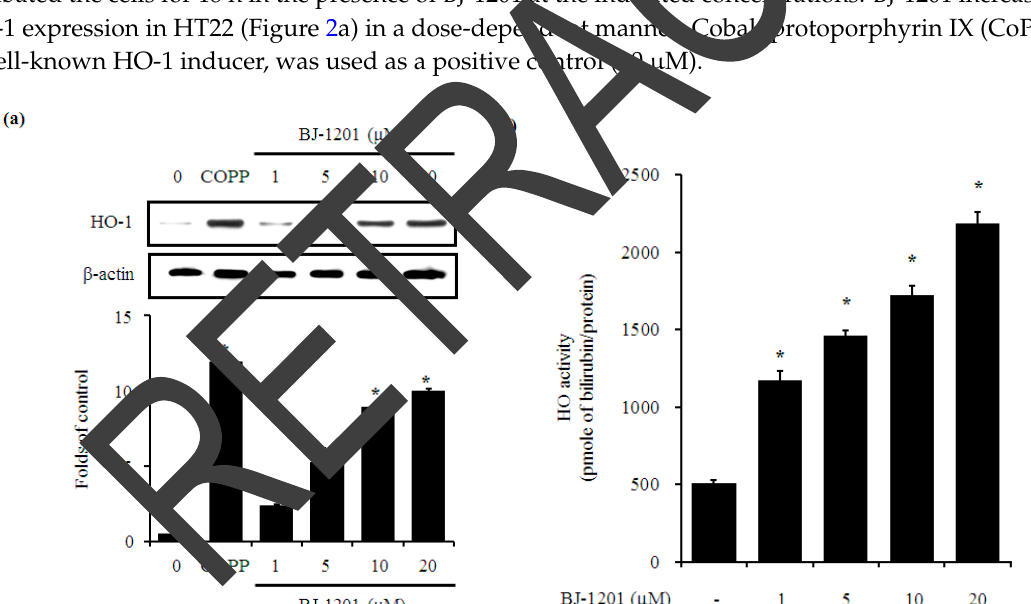
Figure 2. Effects of BJ-1201 on HO-1 expression in HT22 cell. ( a ) Cells were incubated for 18 h with sample (1–20 μ M). Expression of HO-1 was determined by western blot analysis; ( b ) HO activity was determined via bilirubin formation at 12 h after treatment with various concentrations of BJ-1201. Each data represents the mean ± S.D. of three independent experiments are shown. CoPP (10 μ M) was used as the positive control. * p < 0.05 compared with control group.